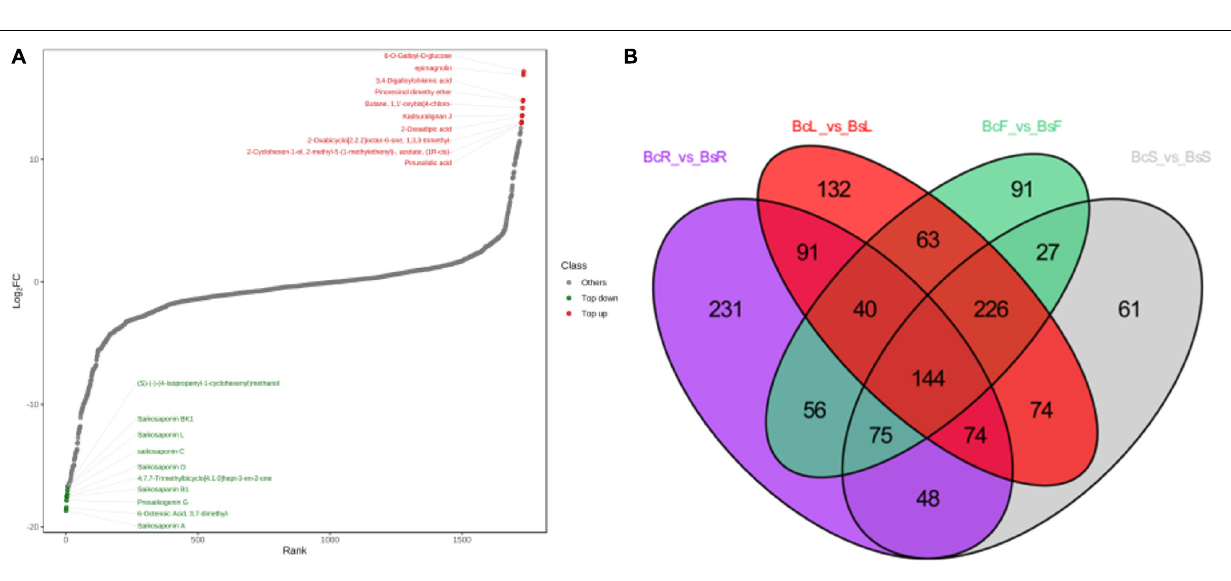
Frontiers in Plant Science |